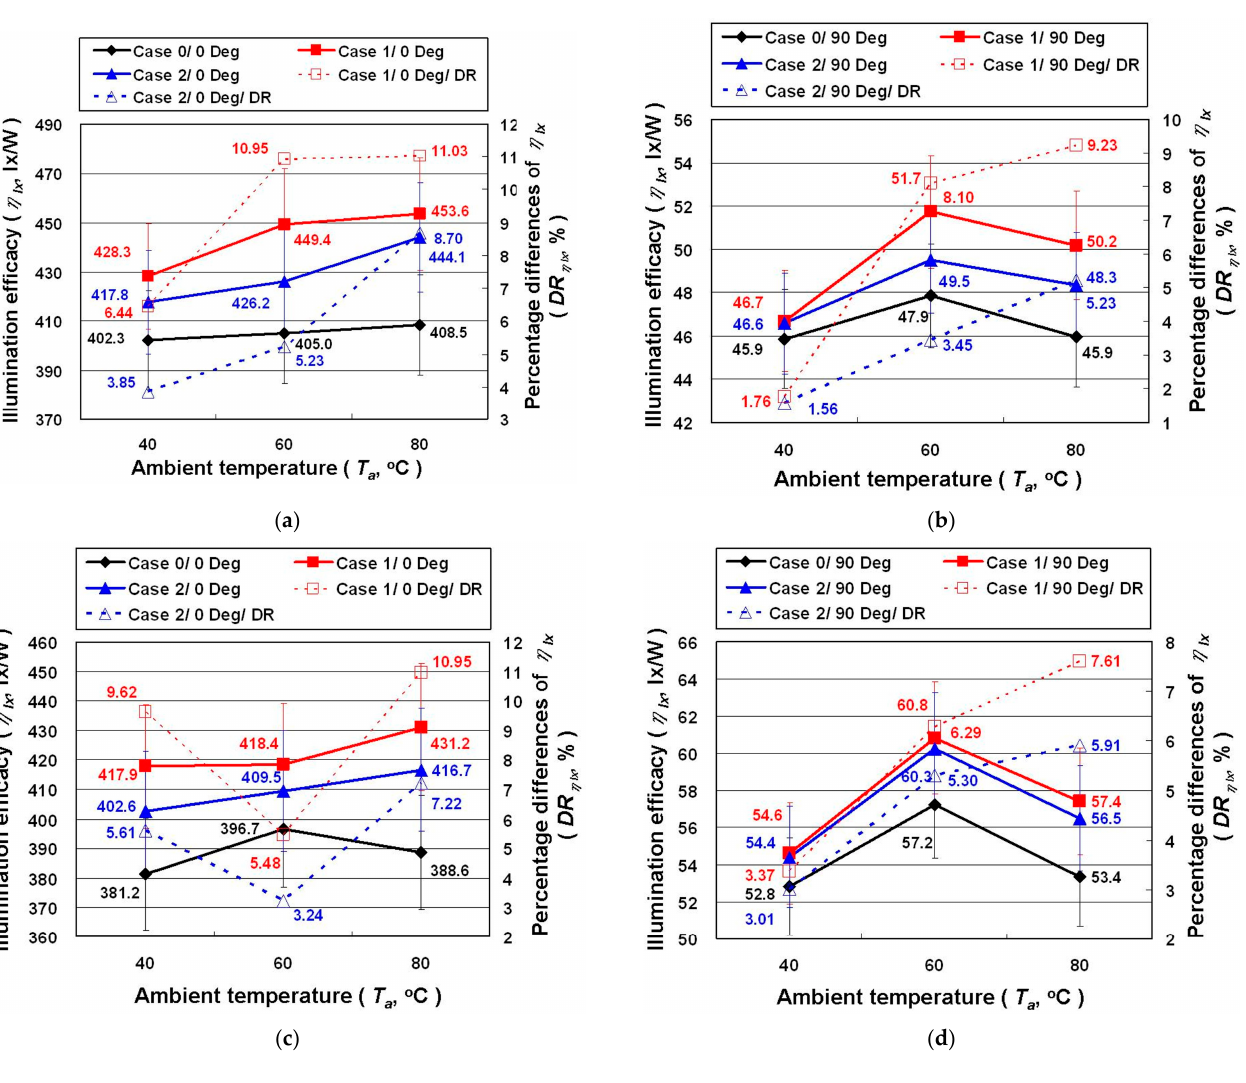
Figure 7. The η lx and the DR η lx of the LED lamps under different experimental parameters: ( a ) high beam/0 degrees; ( b ) high beam/90 degrees; ( c ) low beam/0 degrees; ( d ) low beam/90 degrees.